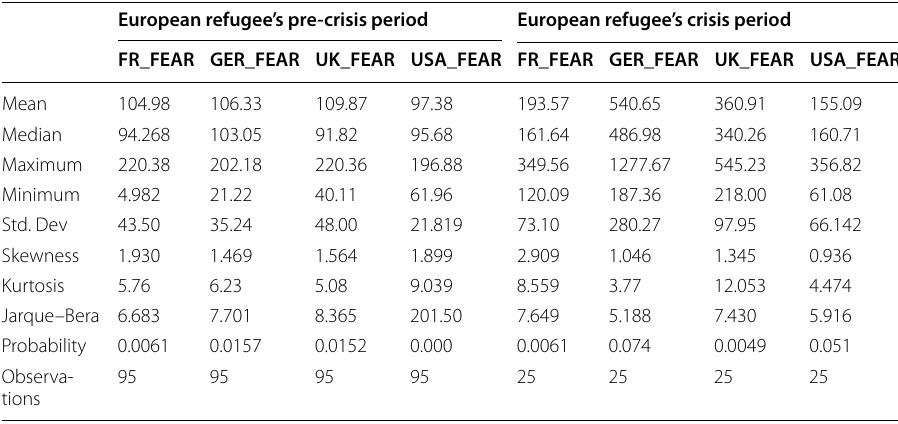
Table 4 Descriptive statistics of pre and at European refugee’s crisis